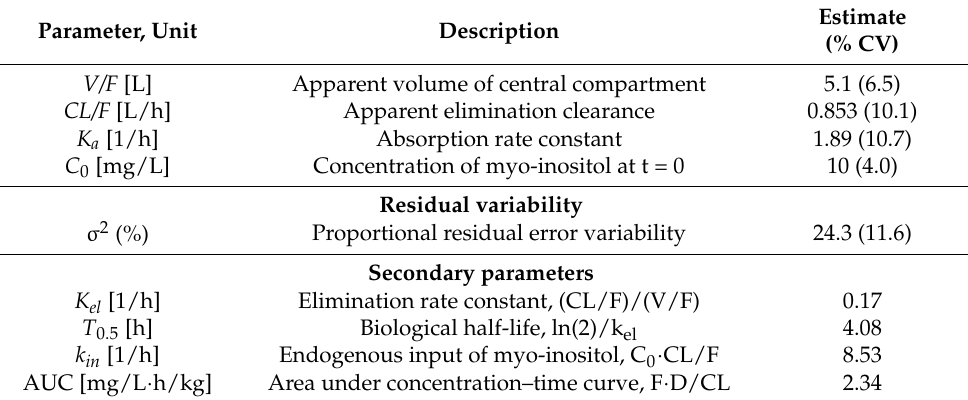
Table 1. Summary of the final PK parameters and residual error variance estimates of myo-inositol. Parameter, Unit